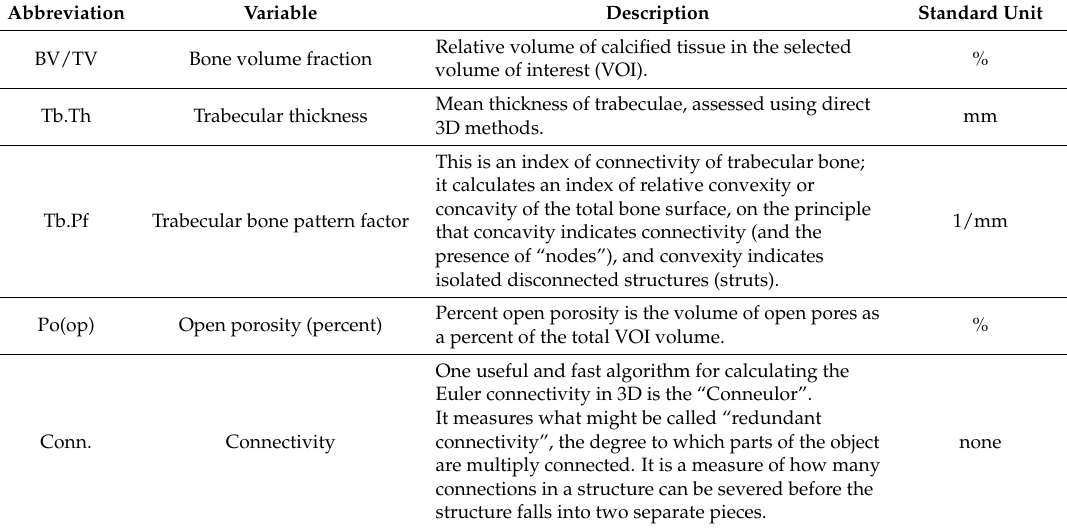
Table 1. The morphometric variables relevant to our study calculated by the CTAn software (according to Bouxsein, M.L., et al. (2010), Gunderson, H.J.G., et al. (1993) and the manual Bruker